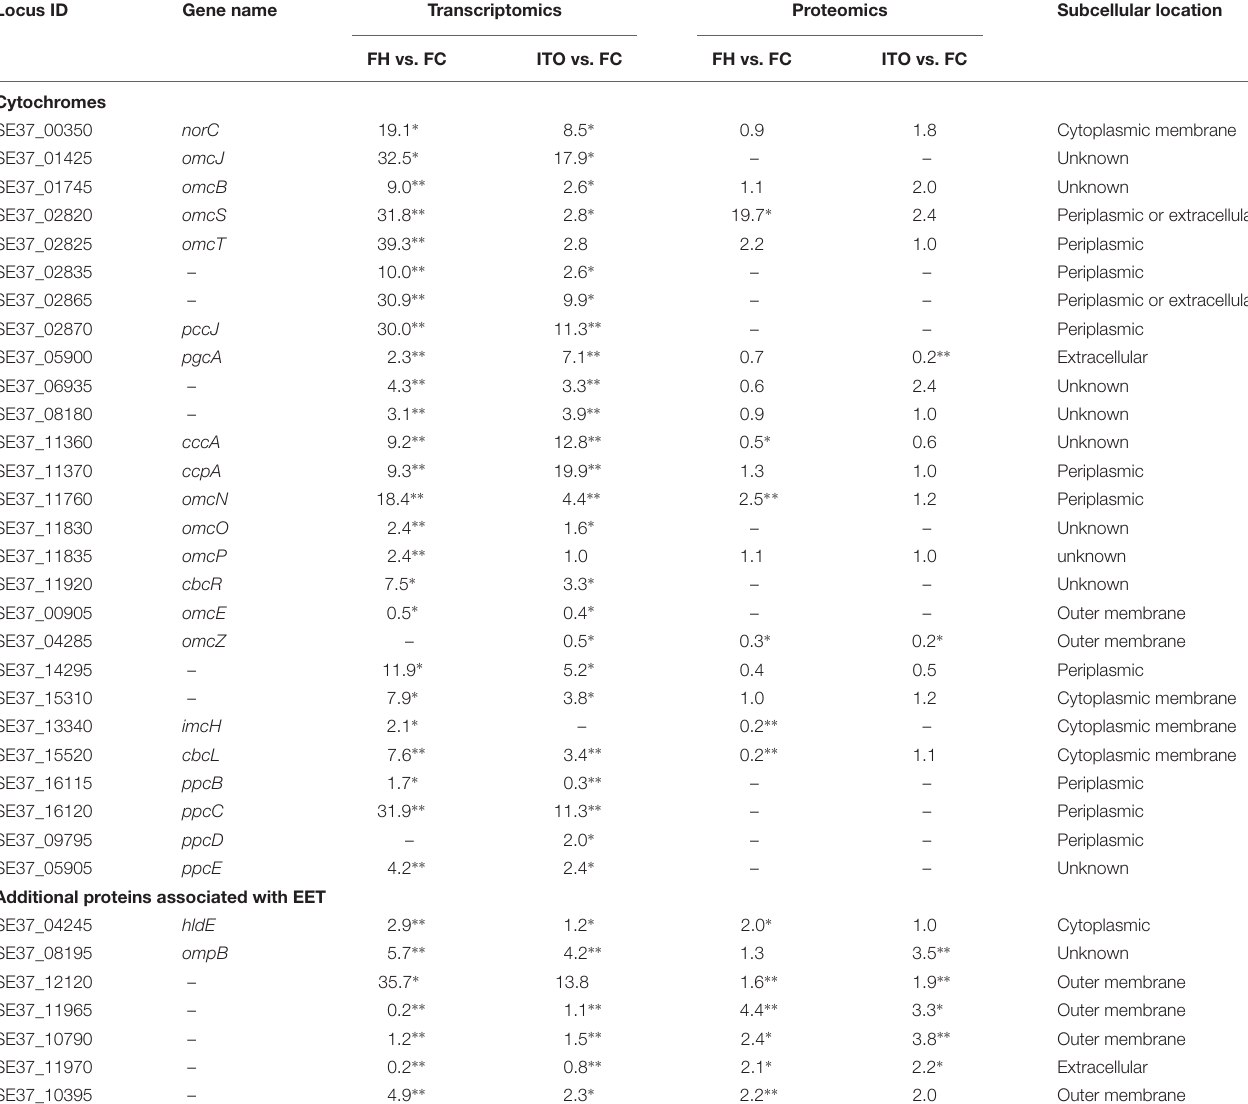
TABLE 1 | The selected important c -Cyts and additional proteins potentially involved in EET. Locus